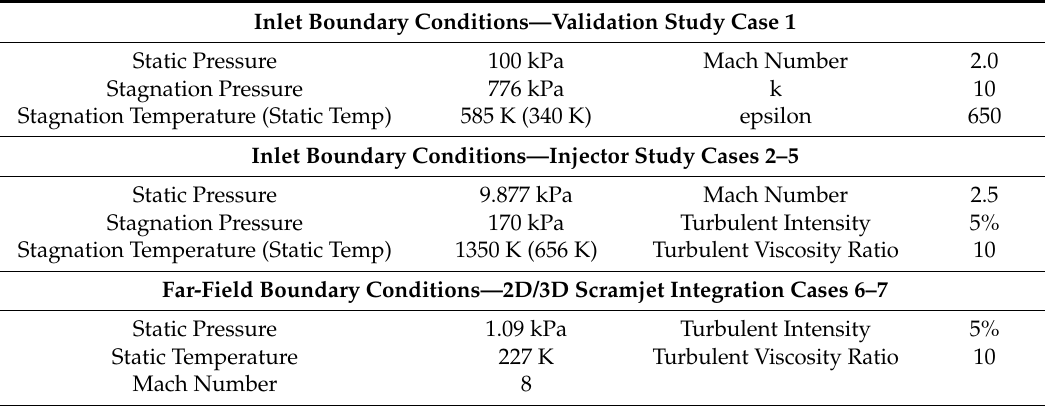
Table A3. Inlet Boundary Conditions—Cases 1–7.